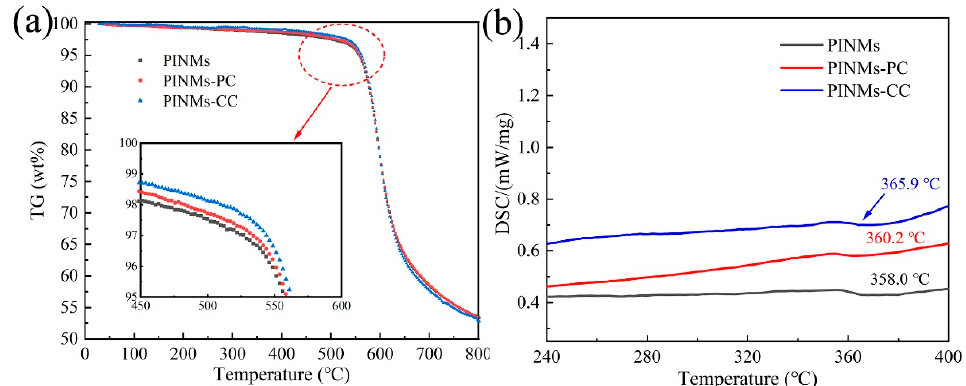
Figure 3. ( a ) TGA curve and ( b ) DSC curve of PI membranes at a heating rate of 10 °C/min under nitrogen atmosphere.